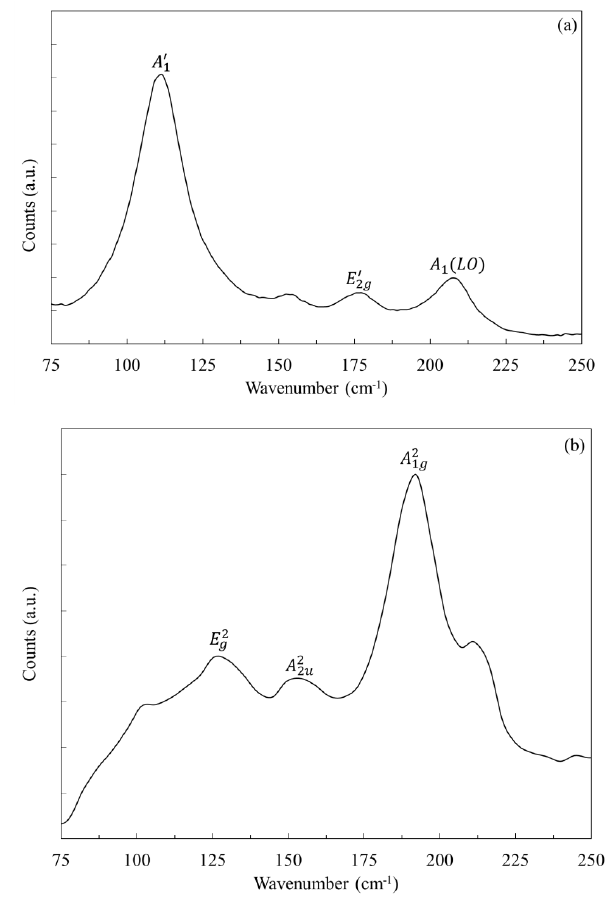
Figure 3. Raman spectrograph of ( a ) γ -InSe ( b ) Sb 2 Se 3